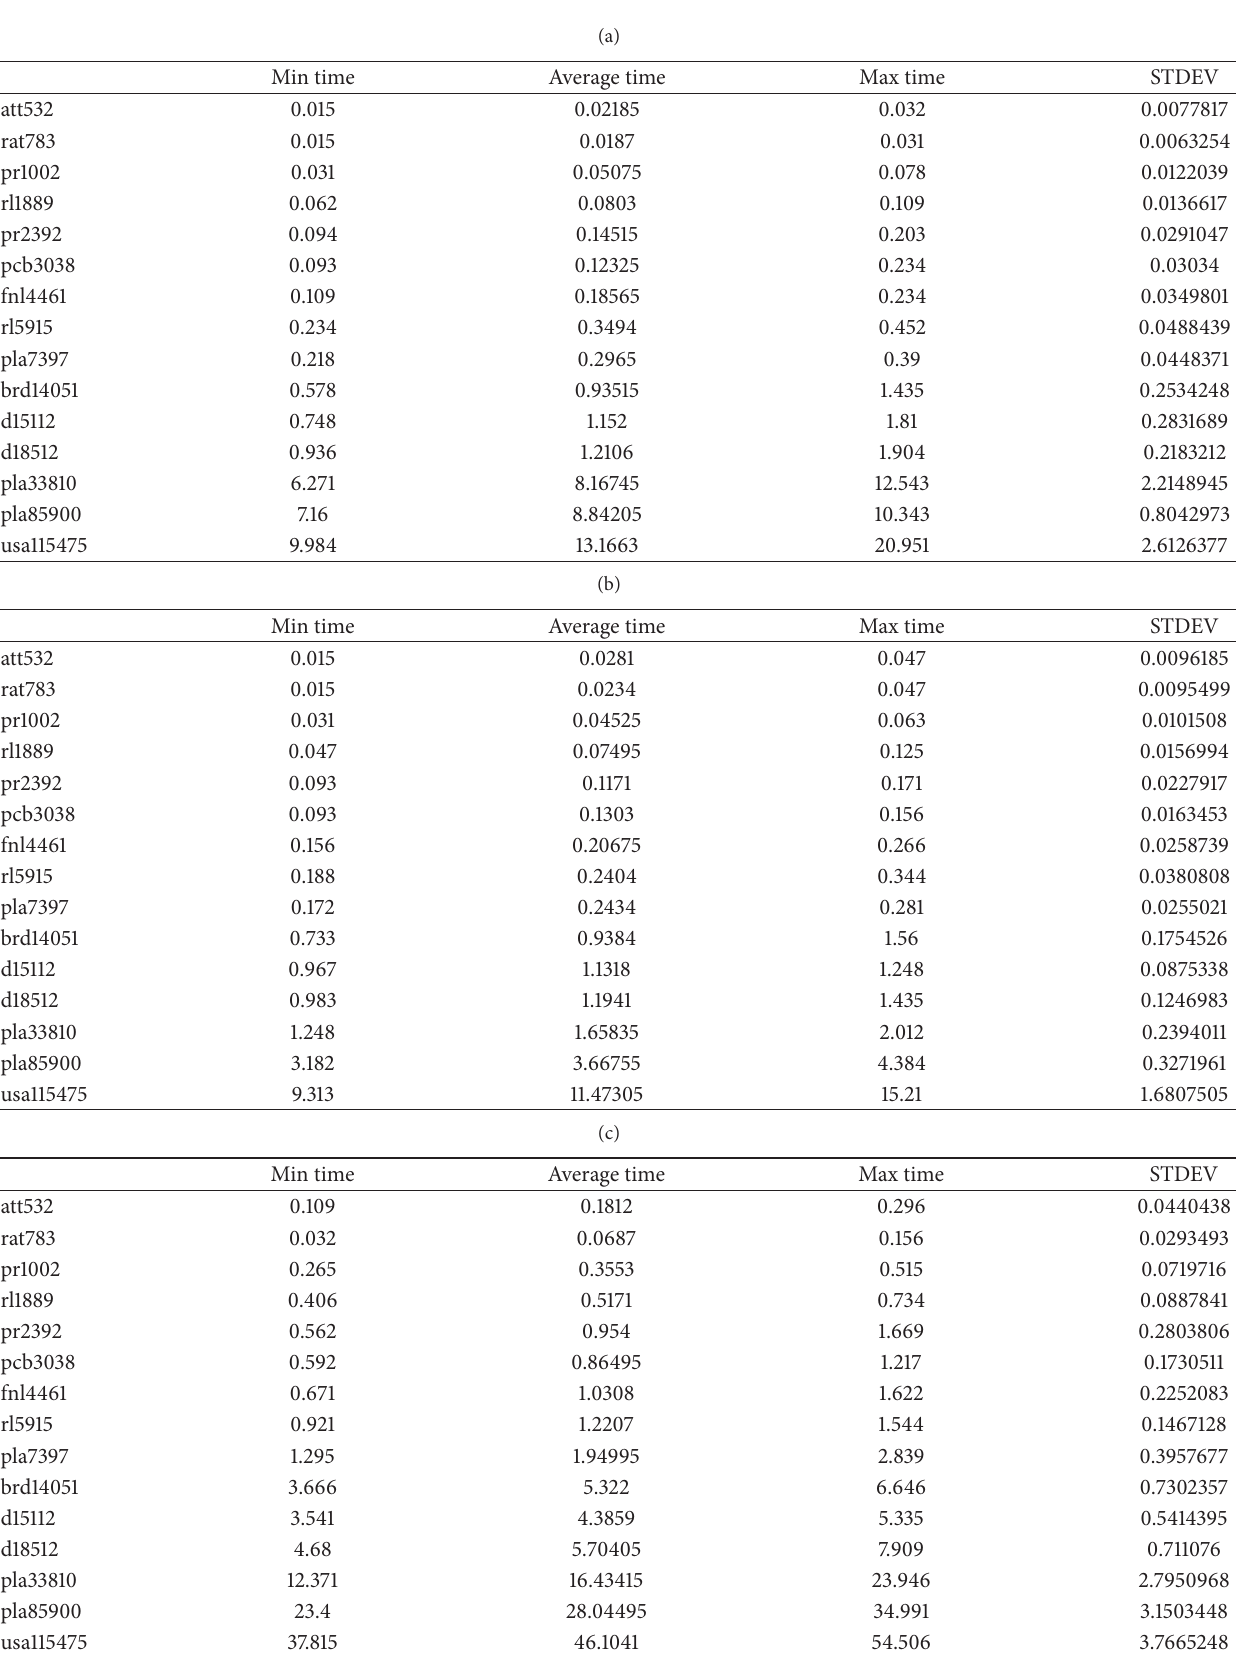
Table 3: (a) 2-Opt runtime results. (b) 3-Opt runtime results. (c) LK runtime